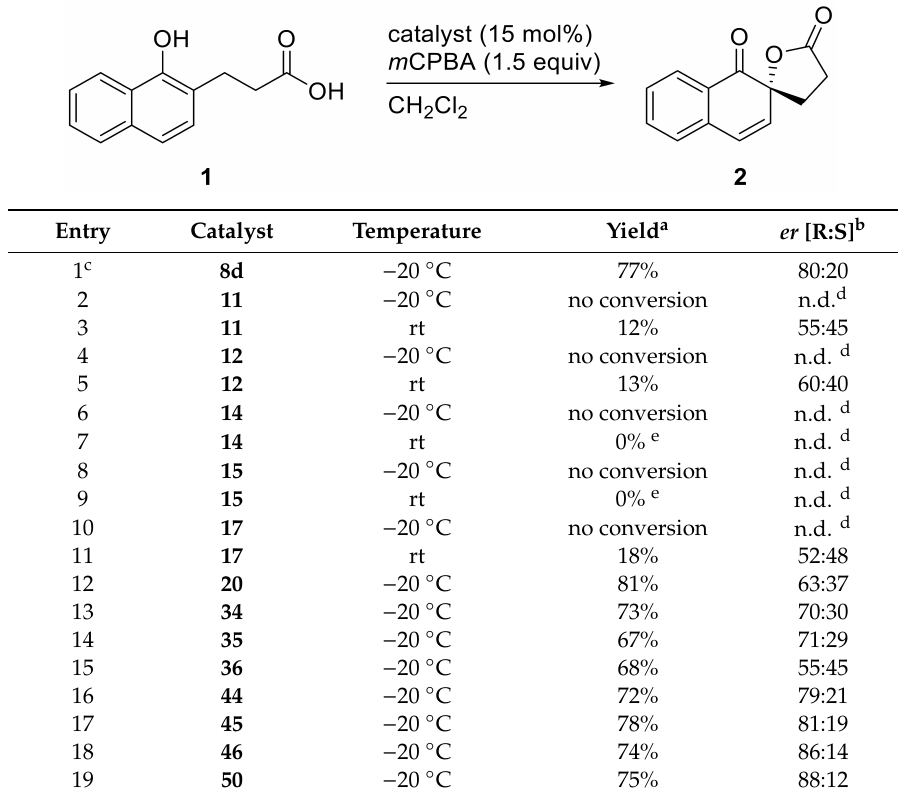
Table 1. Application of catalysts in Kita’s oxidative spirolactonisation of 3-(1-hydroxynaphthalen-2-yl)propanoic acid.